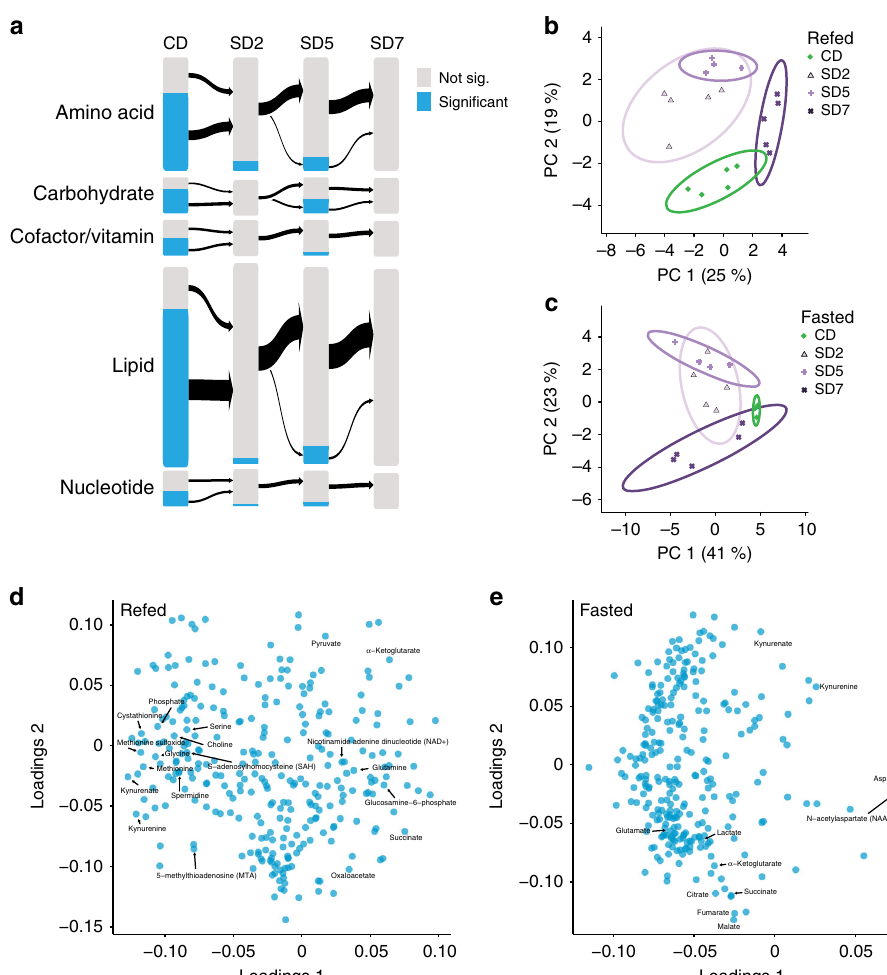
Fig. 6 SD reshapes the metabolic transitions between hunger and satiety in fl y heads. a The effects of short, (2 days, SD2), medium (5 days, SD5), and longer term (7 days, SD7) consumption of a high sugar diet (SD) compared to a control diet (CD) on the magnitude of the metabolite differences between the fasted and refed state on each diet. The size of the bars is proportional to the number of compounds in each metabolite category on the left. In blue are metabolites that were signi fi cantly different between fasted and refed fl ies in each condition (CD, SD2, SD5, and SD7 by Welch ’ s t -test, FDR < 0.1), and in gray metabolites that were not. b , c Projection onto the two most explanatory principal components for compound levels from b refed and c fasted heads of fl ies on CD (green) and fed a SD (purple shades) for 2 days (SD2), 5 days (SD5), or 7 days (SD7). The solid lines represent the 95% con fi dence interval, and percent explained variance is listed in parentheses. d , e Principal component loadings for the d refed and e fasted heads of fl ies fed a CD, or SD2, SD5, or SD7. Labels represent characteristic compounds. Source data are provided as a Source Data fi